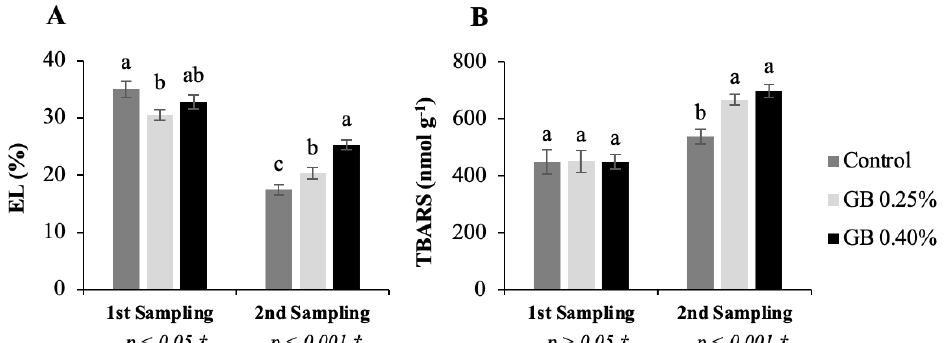
Figure 2. Represents electrolyte leakage (EL) and thiobarbituric acid reactive substances (TBARS) in sweet cherry tree leaves. EL ( A ), and TBARS ( B ), for the cv. Lapins leaves subjected to the different treatments. † Indicates that the p values were calculated from the one-way ANOVA analysis after verifying the assumptions of normality and homogeneity of variances. When a significant effect was observed ( p < 0.05), Tukey’s post-hoc test was applied.